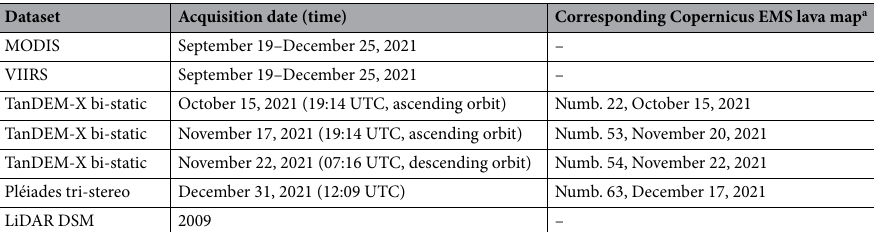
Table 3. Datasets used. a https:// emerg ency. coper nicus. eu/ mappi ng/ list- of- compo nents/ EMSR5 46